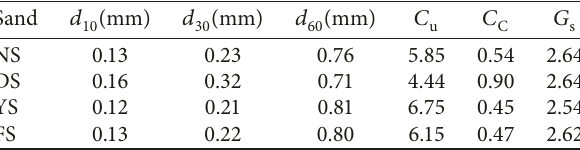
Table 1: Properties of the four types of source sand. Sand